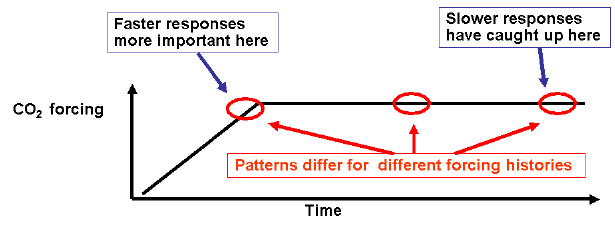
Figure 1. Schematic illustrating a situation where linear mecha- nisms can cause climate patterns to evolve. This represents a sce- nario where global-mean radiative forcing (black line) is ramped up, then stabilized. At the time indicated by the left red oval, responses with shorter timescales are relatively important, due to the recent increase in forcing. At the time marked by the right-hand oval, forc- ing has been stabilized for an extended period, so the responses with longer timescales (such as sea-level rise) have had more time to re- spond to the initial forcing